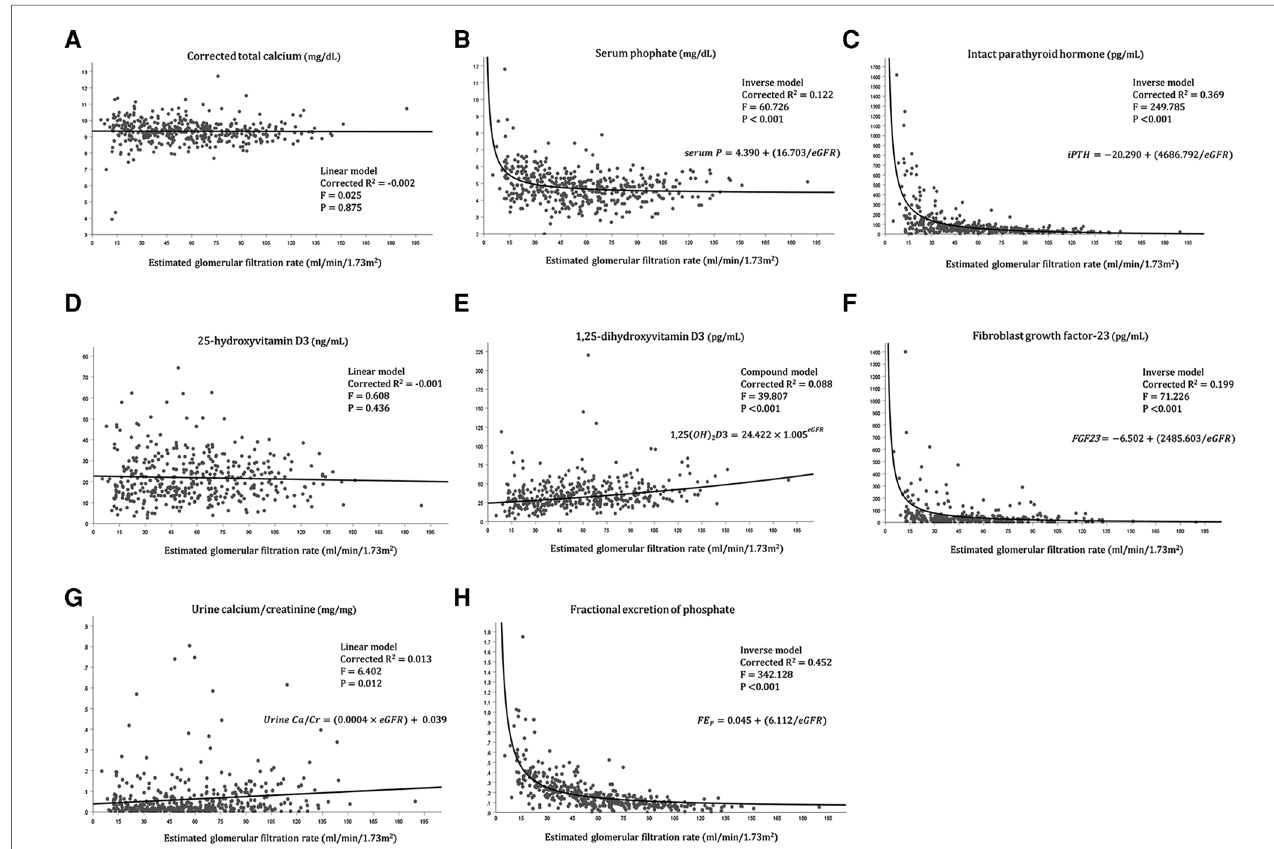
FIGURE 1 Relationship between each variable of mineral metabolism and the eGFR. ( A ) Relationship between corrected calcium level and eGFR, ( B ) Relationship between serum phosphate level and eGFR, ( C ) Relationship between intact parathyroid hormone level and eGFR, ( D ) Relationship between 25-hydroxyvitamin D3 level and eGFR, ( E ) Relationship between 1,25-dihydroxyvitamin D3 level and eGFR, ( F ) Relationship between fi broblast growth factor-23 and eGFR, ( G ) Relationship between Urine calcium/creatinine ratio and eGFR, ( H ) Relationship between fractional excretion of phosphate and